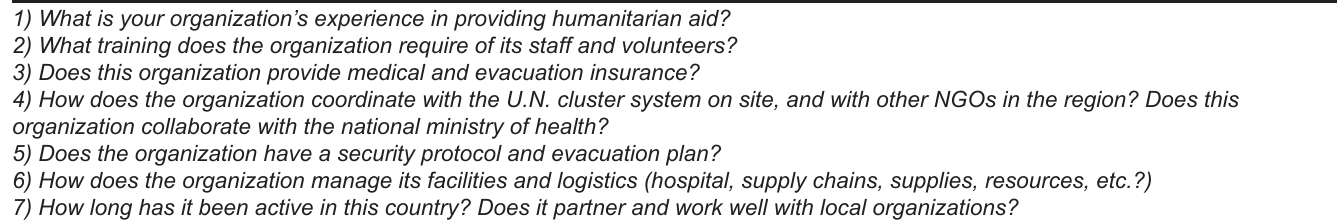
Figure 3. Questions to ask to determine whether or not an organization is well-prepared for a humanitarian